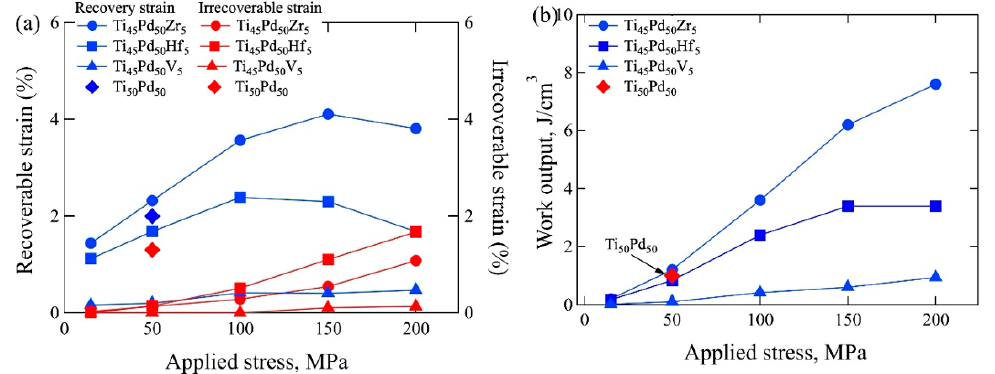
Figure 5. Changes in ( a ) recoverable strain and irrecoverable strain, and ( b ) work output for the applied stress of Ti 50 Pd 50 [58], Ti 45 Pd 50 Zr 5 [45], Ti 45 Pd 50 Hf 5 , and Ti 45 Pd 50 V 5 derived from the strain–